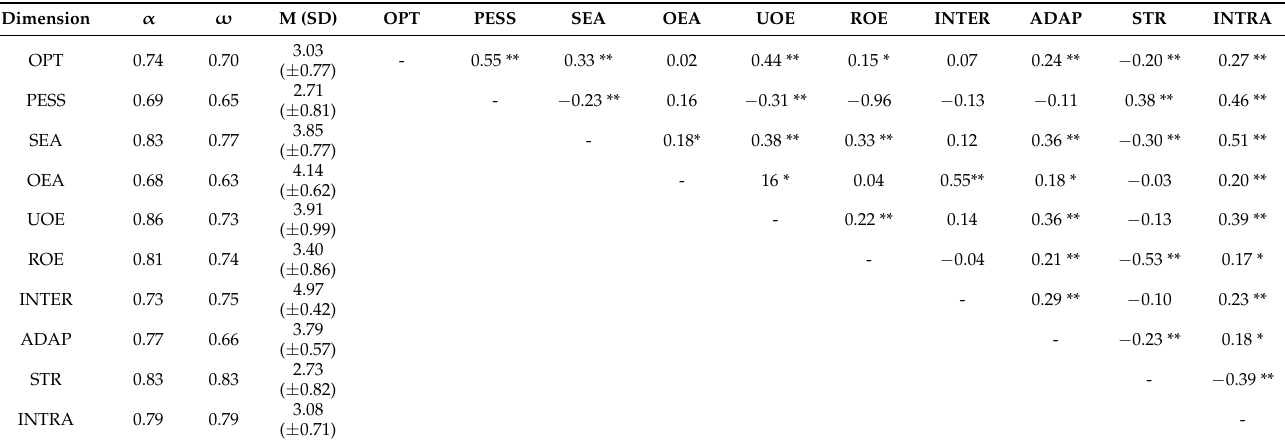
Table 1. Internal consistency, means, standard deviation, and correlations (Spearman’s Rho) between the variables optimism, pessimism, and emotional